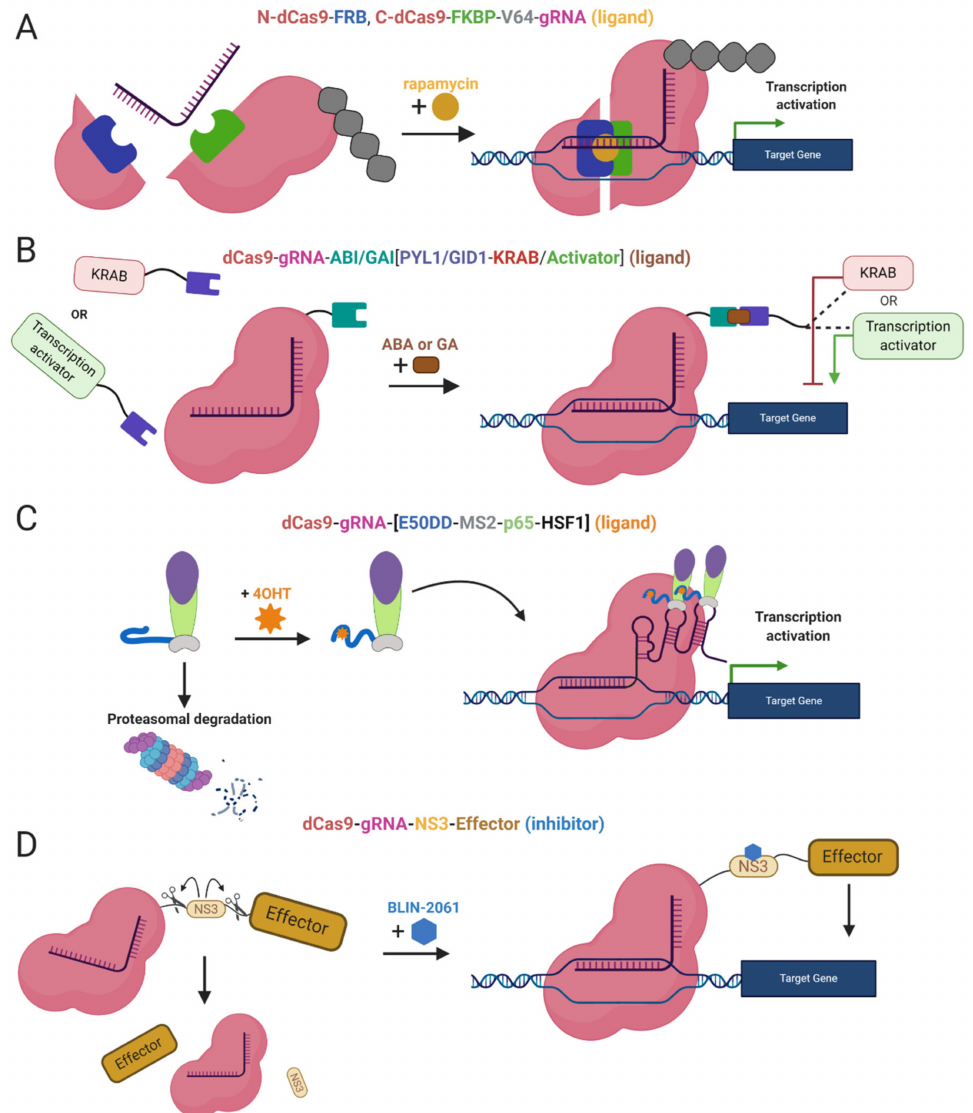
Figure 3. Chemically Inducible Epi-editors Systems. ( A ) Split dCas9-VP64 complex with one ligand-binding domain (LBD) at N-terminus of dCas9 and second LBD at C-terminus. Both LBDs bind a ligand (rapamycin, yellow) and bring together both halves of dCas9, resulting in the formation of functional gene activation complex; ( B ) Inducible system using phytohormones and phytohormone binding domains ABI or GAI fused to dCas9, and PYL1 / GID1 fused to the e ff ector-activator (VPR) or KRAB. The interaction via a ligand (abscisic acid or gibberellin) activates the epi-editor complex; ( C ) Inducible SAM system with a destabilized domain of estrogen receptor 50 (ER50DD). In the absence of a ligand-4OHT (4-hydroxytamoxifen), ER50DD protein is destabilized and leads the whole ER50DD-MS2-p65-HSF1 to proteasomal degradation, once the ligand is present it binds ER50DD and stabilizes it. Then complex is not degraded and therefore capable of interacting with RNA aptamers a form functional activation complex. ( D ) Inducible system with proteolytic cleavage. A part of the linker, between dCas9 and e ff ector domain, is NS3 protein, protease from hepatitis C virus that cleaves peptide bonds in its vicinity. When NS3 is active, it cleaves the linked and abrogates the function of the epi-editor complex. The protease can be blocked by inhibitorBLIN-2061, leading to restoration of the epi-editor and its activity. The e ff ect of ligands or inhibitors in the system mentioned above is reversible. After the inhibitor / ligand is diluted or metabolized, the chemical epi-editor systems are